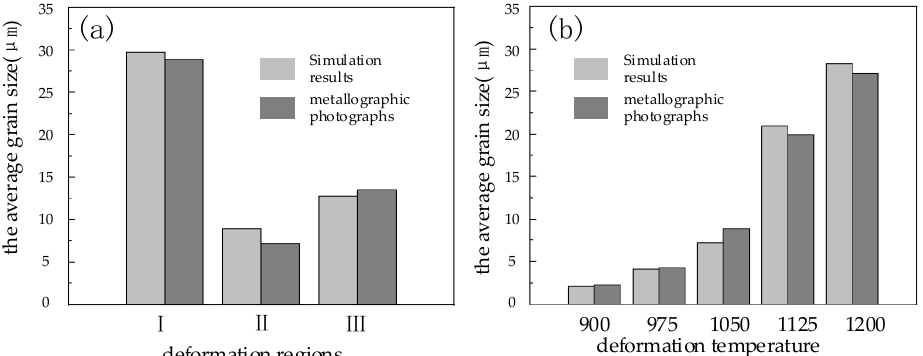
Figure 14. The comparison of the average grain size between simulation results and metallographic photographs: ( a ) The comparison of the average grain size under different deformation regions at 1050 °C and 0.1 s −1 ; ( b ) The comparison of the average grain size under different temperature at 0.1 s −1 .